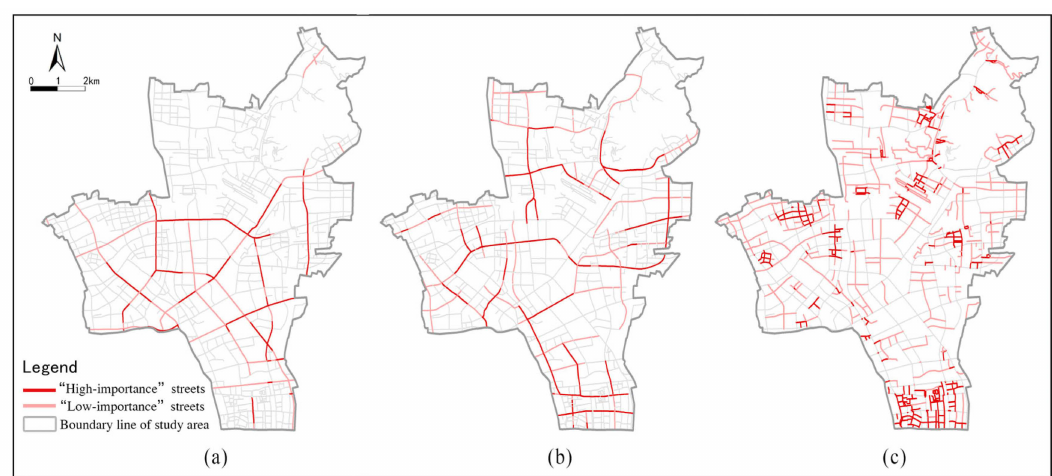
Figure 20. Importance evaluation of streets at different grades. ( a ) Arterial road; ( b ) Secondary trunk road; ( c ) Branch